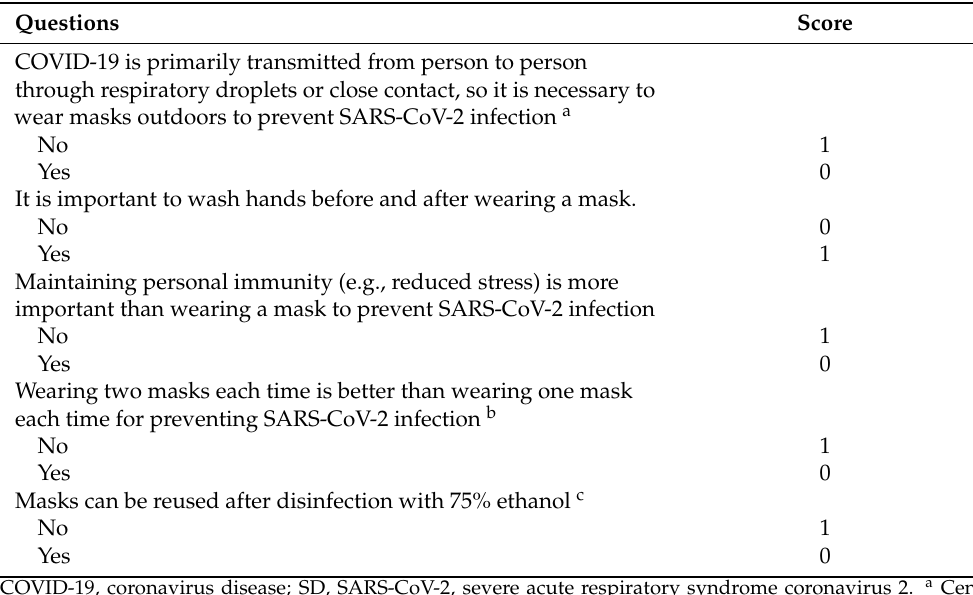
Table A2. Evaluation of knowledge on mask usage during the COVID-19